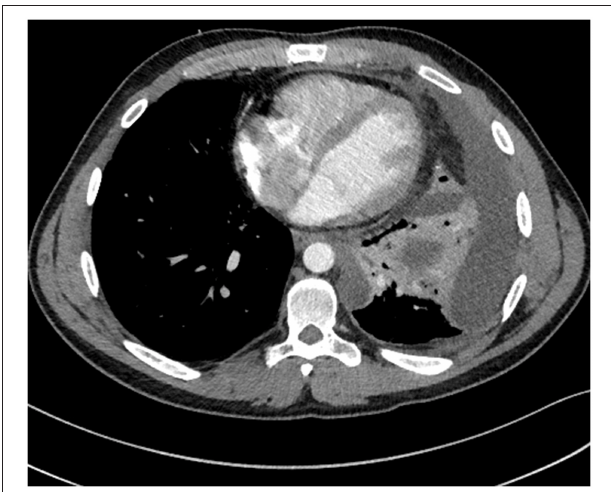
FIGURE 1 | A computed tomography (CT) scan showed a multi-loculated left pleural